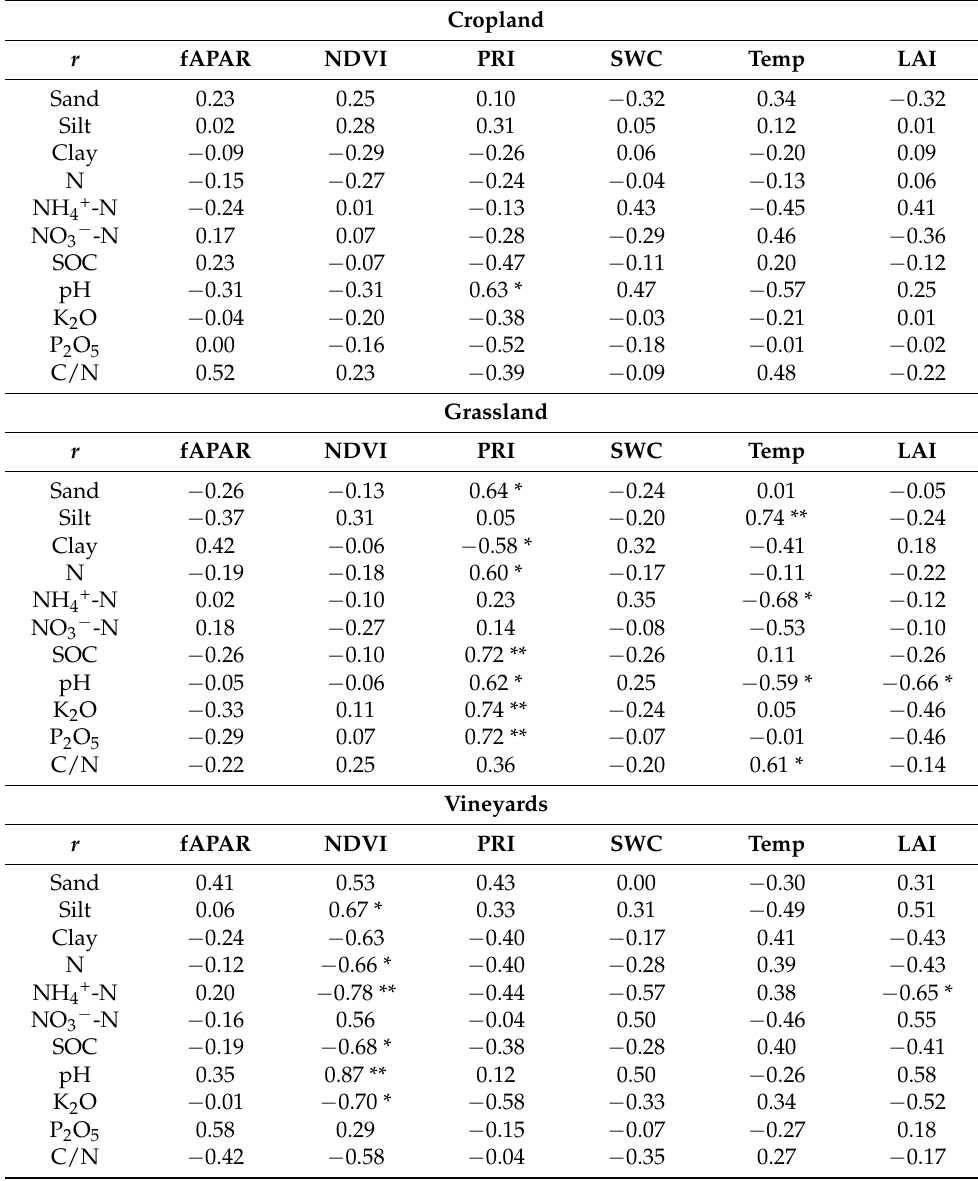
Table 3. Pearson correlation analysis ( r ) and p -value between the investigated plant and soil parame- ters. Correlation is significant * at the 0.05 and ** at the 0.01 levels. n =